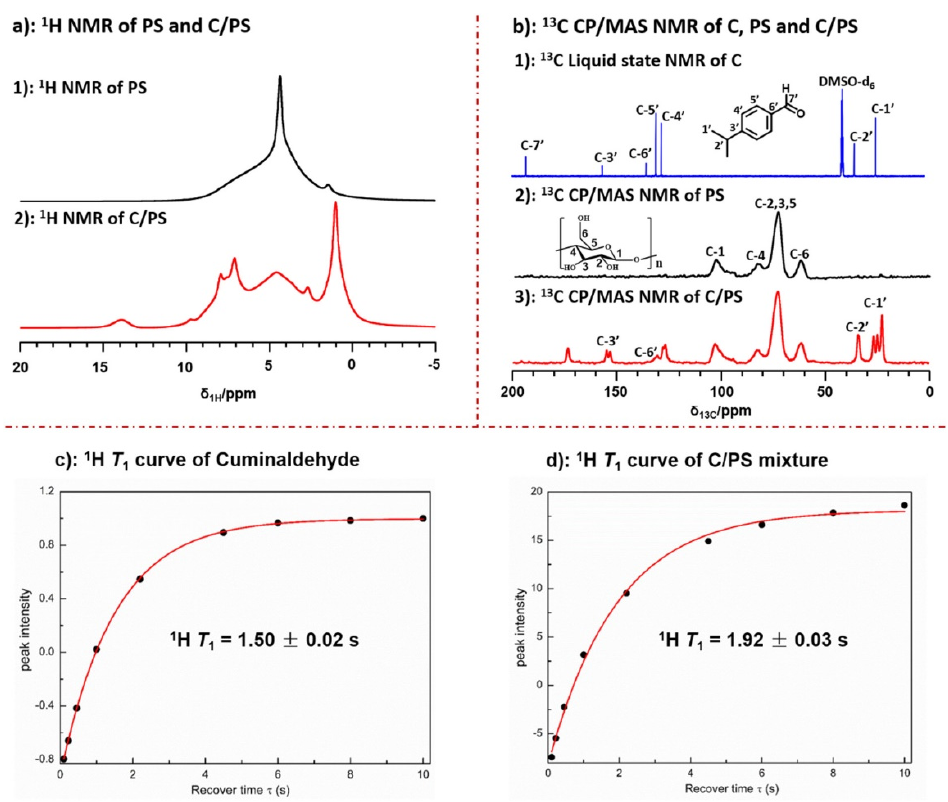
Figure 7. ssNMR techniques for measuring the structure and relaxation properties of PS (black) and C/PS (red): ( a ) single pulse 1 H MAS NMR spectra for PS and C/PS; ( b ) 13 C CP MAS NMR spectra for PS and C/PS compared to solution state spectrum of cuminaldehyde; and ( c ) 1 H T 1 relaxation curve for cuminaldehyde; and ( d ) 1 H T 1 relaxation curve for C/PS. Adapted with permission from Ref. [117]. Copyright 2022, Elsevier.